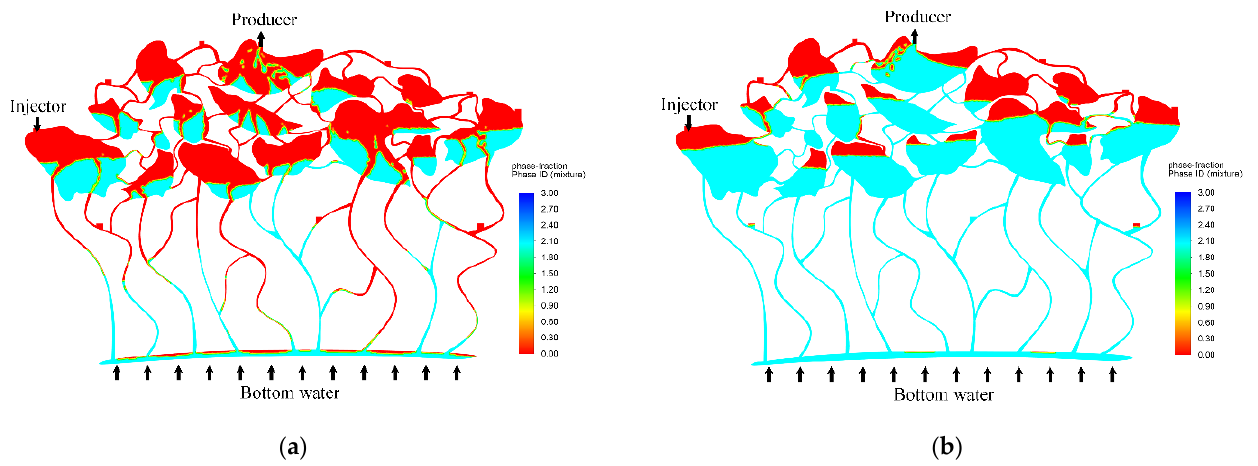
Figure 5. Fluid distribution in different displacement stages of 60 MPa bottom water: ( a ) initial stage; ( b ) last stage.